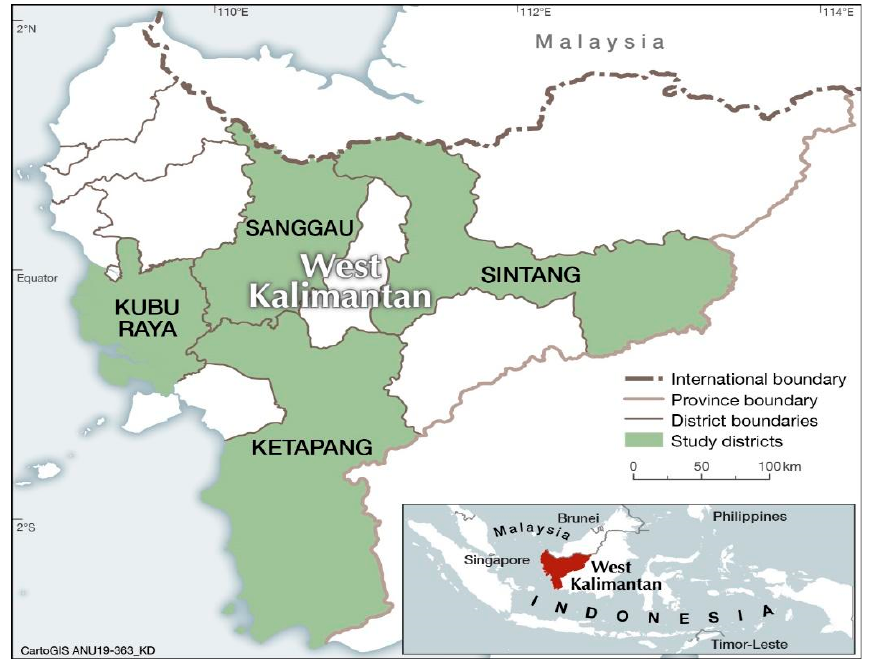
Figure 1. Location of the Fire-Prevention Trial.